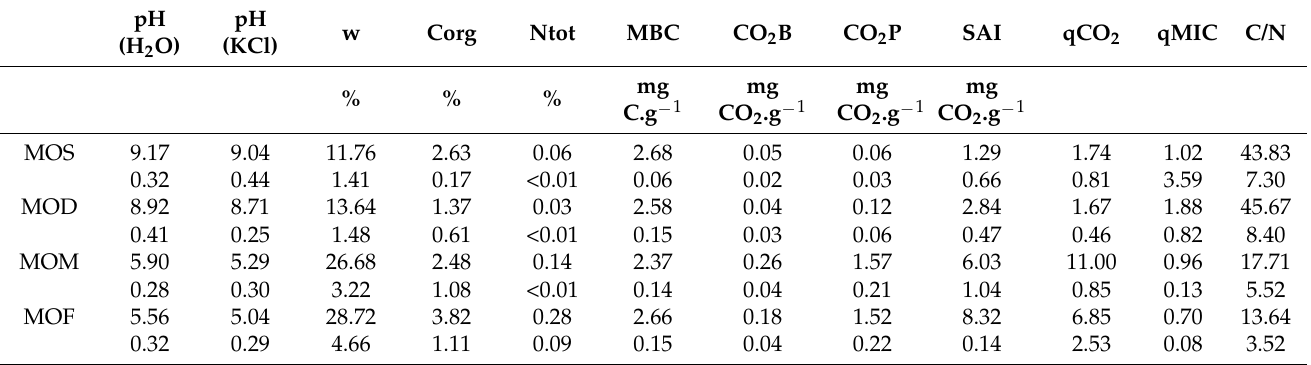
Table 2. Chemical and microbiological properties of soils (MOS, ash sediment; MOD, heterogeneous mixture of ash and natural soil; MOM, meadow; MOF, forest); pH (H 2 O/KCL), negative log of the hydrogen ion concentration; w, water content in the sample; Corg, total organic carbon; Ntot, total organic nitrogen; MBC, microbial biomass carbon (dry weight); CO 2 B, basal respiration (per 24 h); CO 2 P, potential respiration (per 24 h); SAI, substrate availability index (CO 2 P/CO 2 B); qCO 2 ,